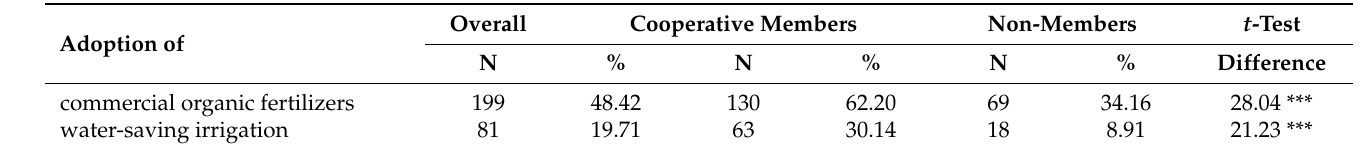
Table 1. Comparative analysis of green technology adoption behaviors among cooperative-member farmers and non-member